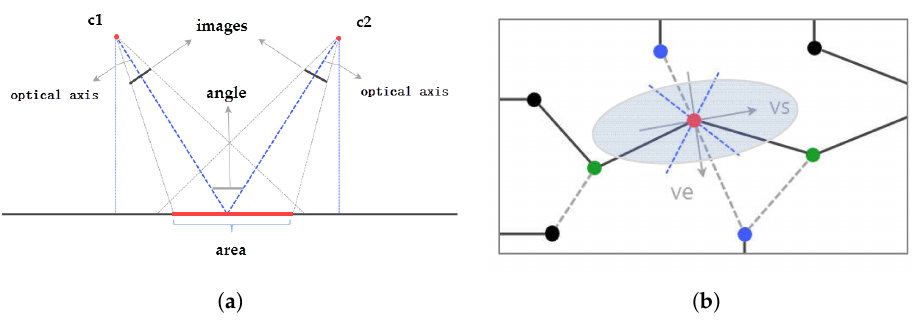
Figure 2. Illustrations for ( a ) edge weight and ( b ) edge expansion [17].